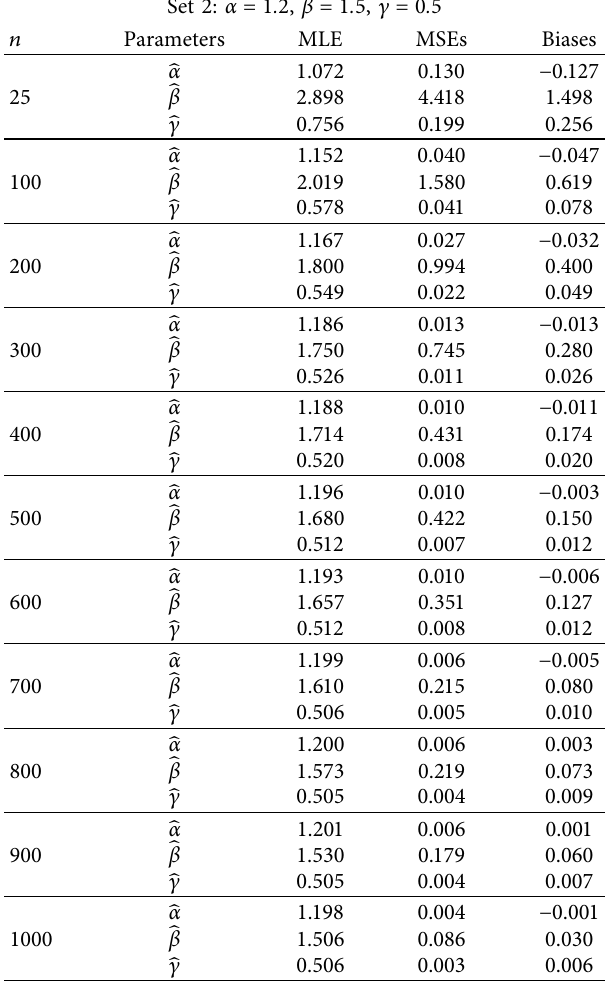
Table 2: Monte Carlo simulation results of the HTBPT–Weibull